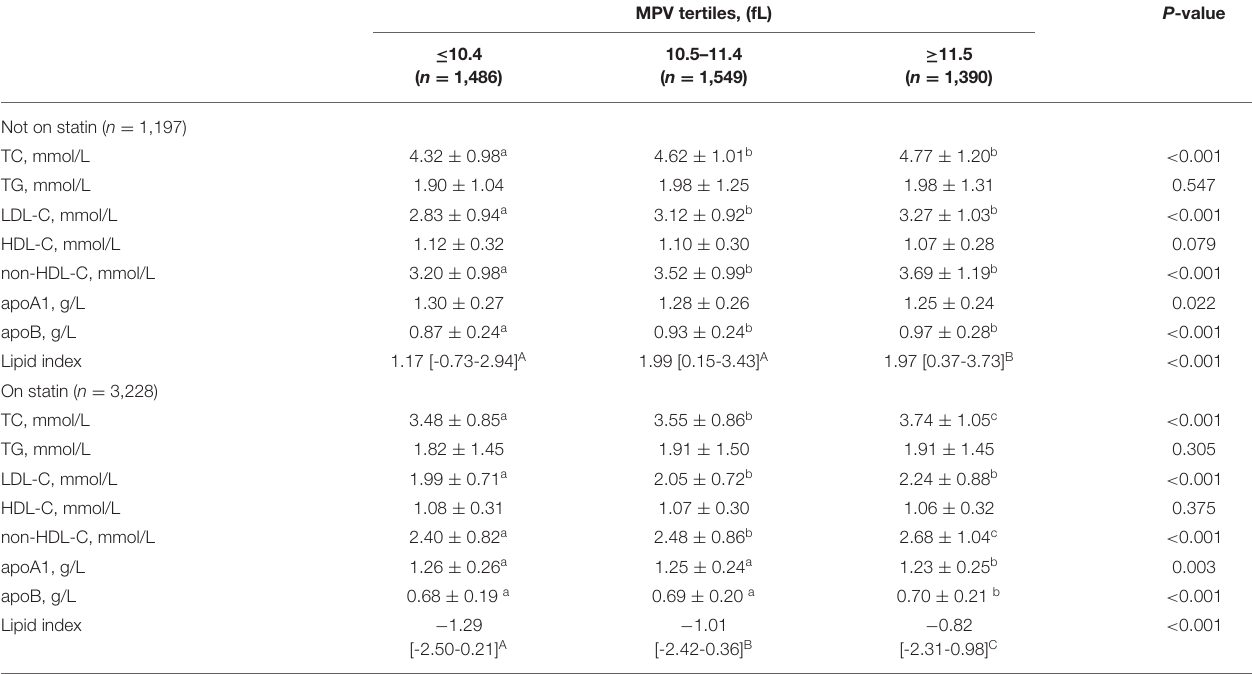
TABLE 5 | Statin-stratified lipid levels by MPV in CAD, adjusted by age and